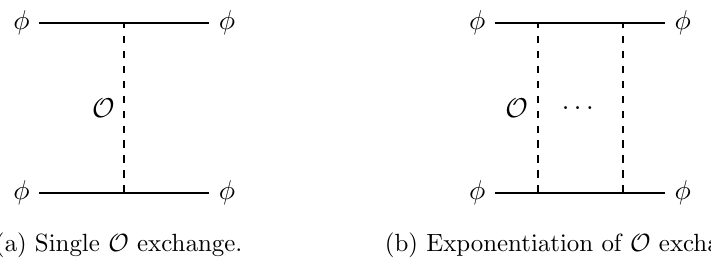
Figure 6. Large-spin diagrams illustrating the contribution to the anomalous dimensions of [ (cid:30)(cid:30) ] n from the exchange of O .